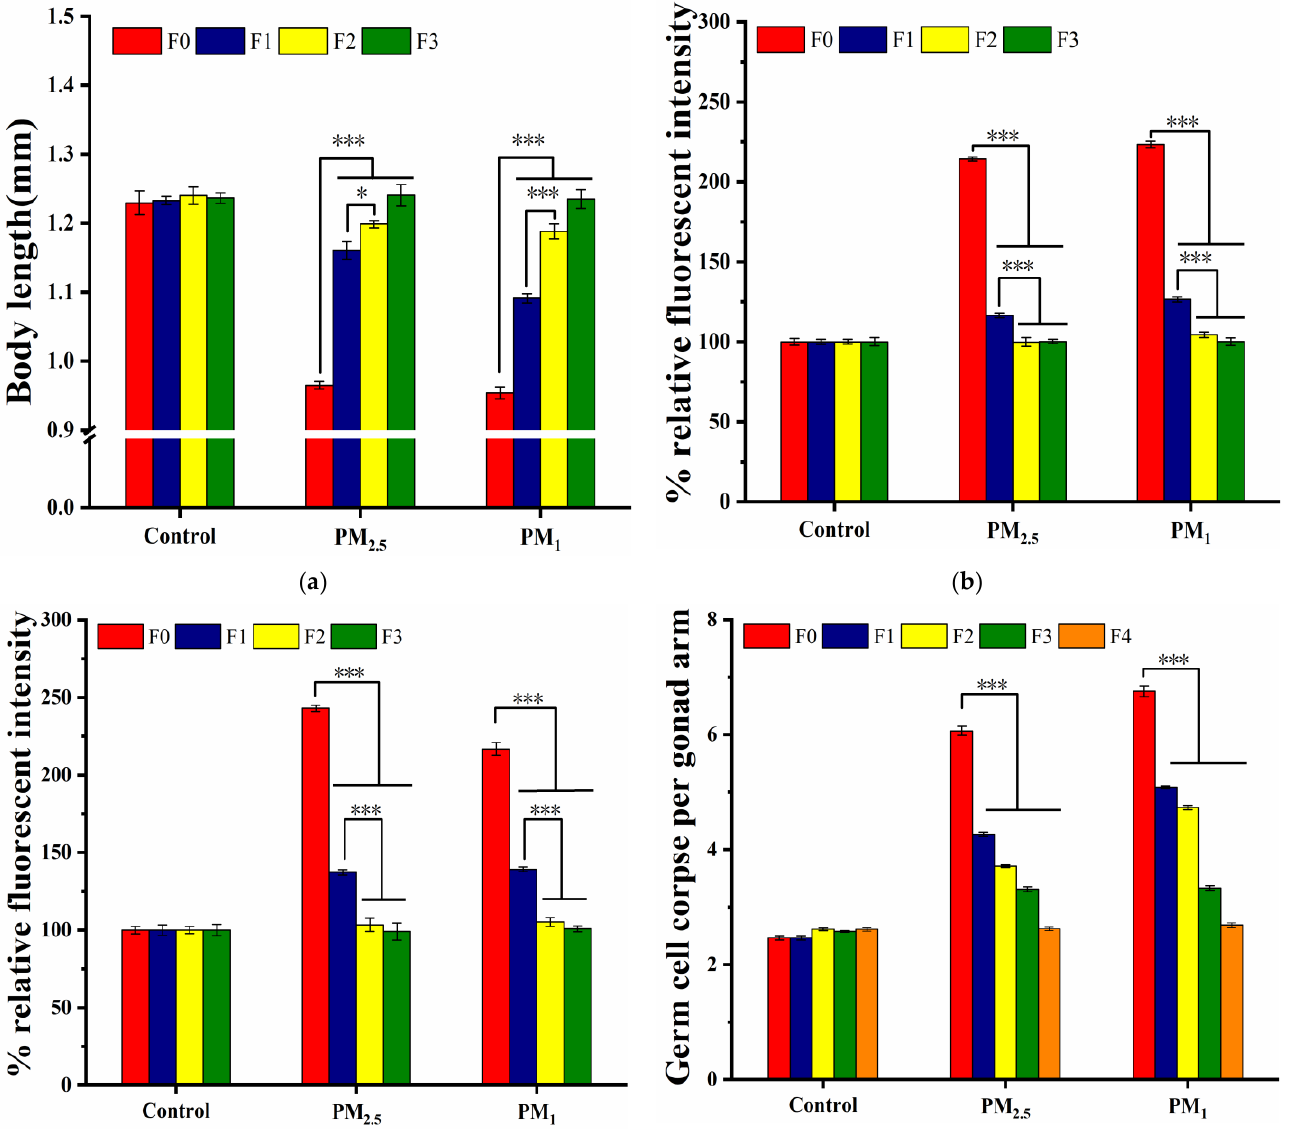
Figure 7. Effects of PM 2.5 and PM 1 exposure on nematodes and their offspring: ( a ) body length; ( b ) intensity of intestinal autofluorescence; ( c ) ROS production; ( d ) number of apoptotic germ cells. L4 stage larvae were selected for 24 h acute exposure. PM 2.5 and PM 1 samples in winter were selected and the exposure concentrations of PM were 1000 µg/mL. Bars represent means ± SEM. * p < 0.05, *** p < 0.001.